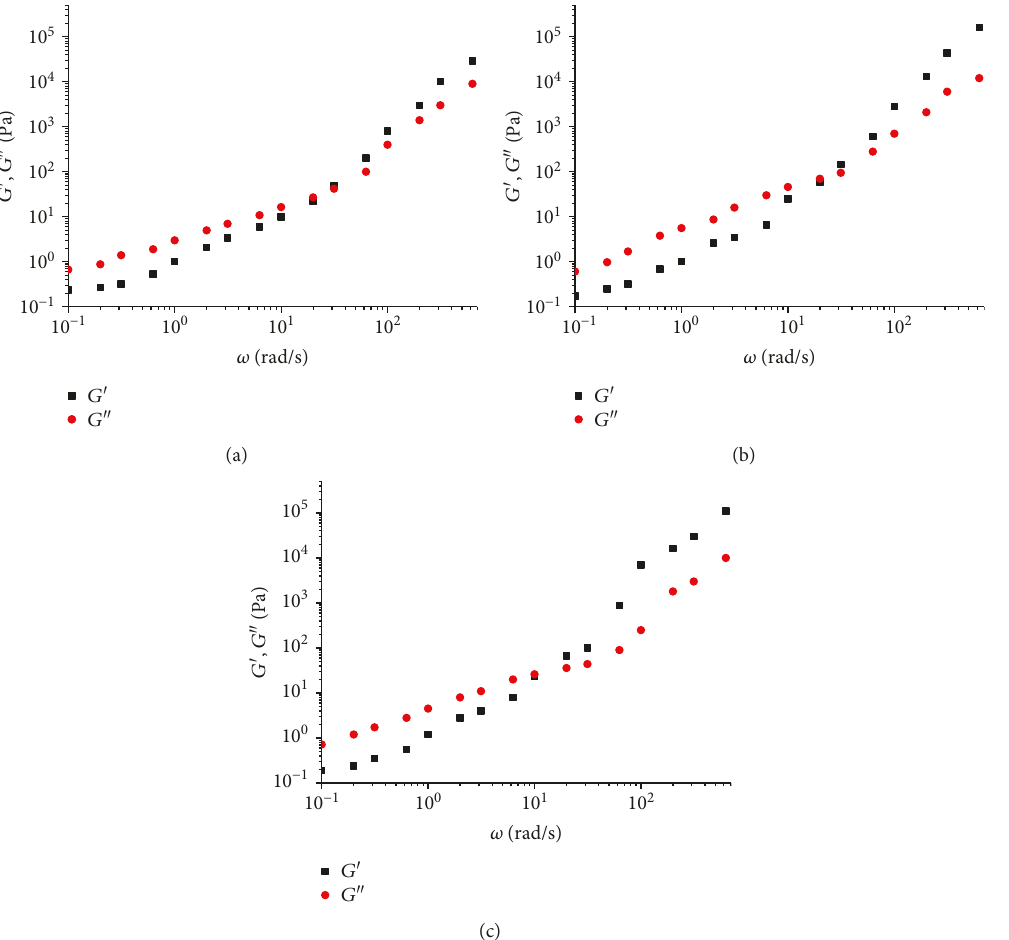
Figure 4: Angular frequency sweep for the polythiourethane system at (a) 55 ° C, (b) 65 ° C, and (c) 75 ° C with the strain of 1%. The changes of G ′ and G ″ with frequency were